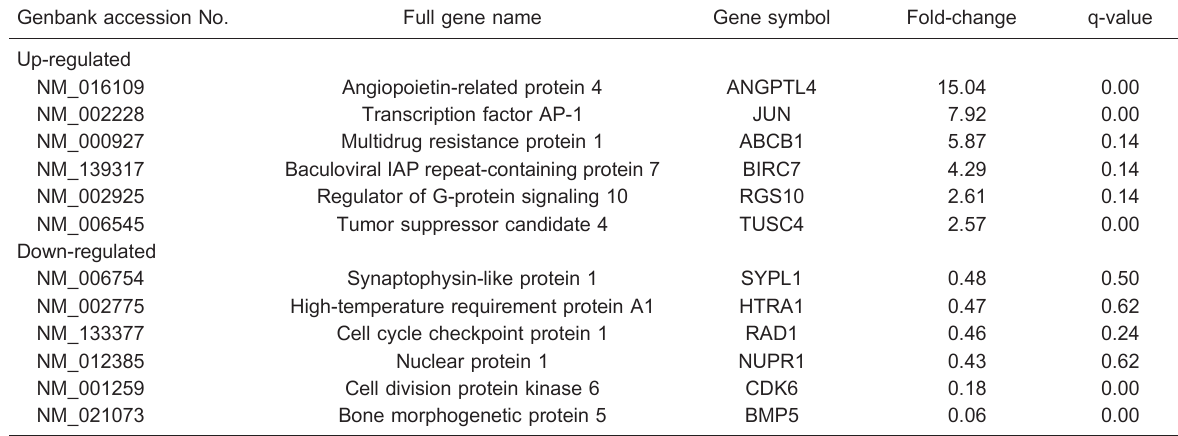
Table 2. Representative mRNAs that are differentially expressed between Hep-2 and Hep-2/v cells. Genbank accession